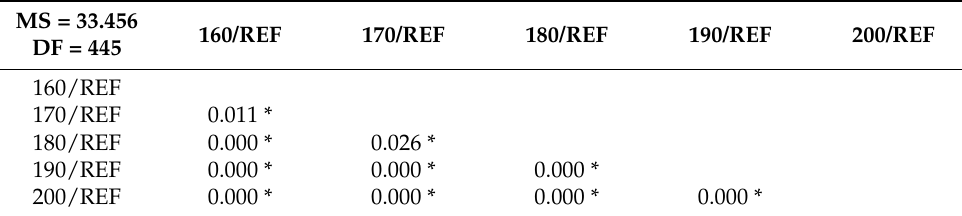
Table A6. Duncan ´ s multiple range test for changes in thermal effusivity. MS =